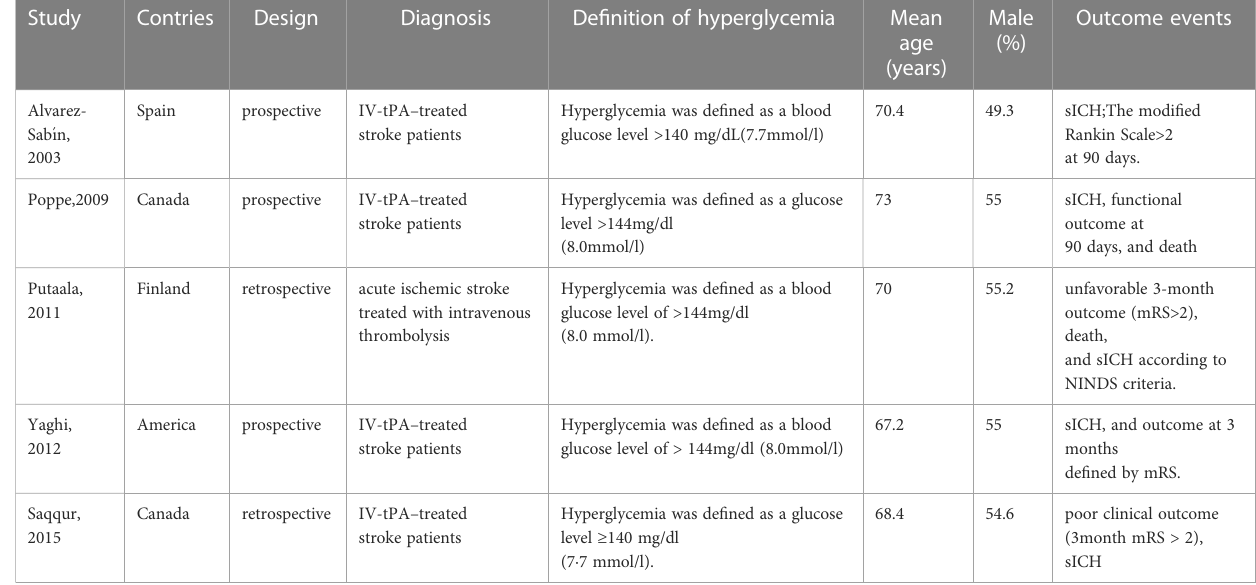
patients had 90-day mRS scores > 2 during the follow-up period. The results from the meta-analysis indicated that blood glucose level at admission was independently associated with a higher risk of 90-day mRS scores > 2 (High Glucose vs Non-high Glucose, OR: 1.82, 95% CI: 1.52-2.19, I2 = 0%; Figure 2B). The results from sensitivity analyses, which excluded one data set at a time, were consistent (OR: 1.82 95%CI:1.52-2.19, p all <0.0; Figure 3B). Higher blood glucose levels increase the morality at 90 days Three cohort studies including 2144 stroke patients who received intravenous tissue plasminogen activator evaluated the association